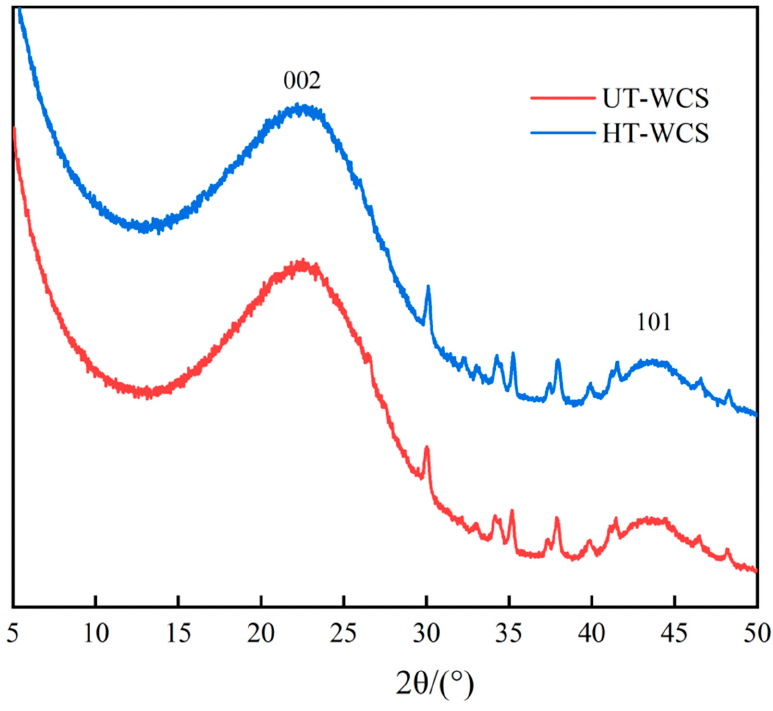
Figure 7. The wide-angle X-ray di ff raction graph of the WCS.